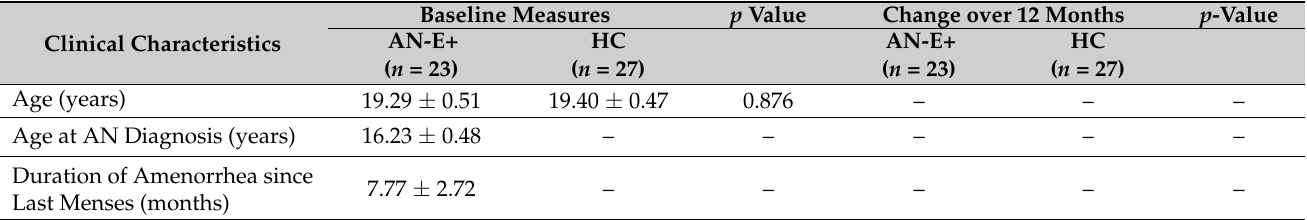
Table 1. Baseline characteristics and change in clinical characteristics, anthropometric measures, and body composition over 12 months for AN-E+ -17 β -E2 patch and HC